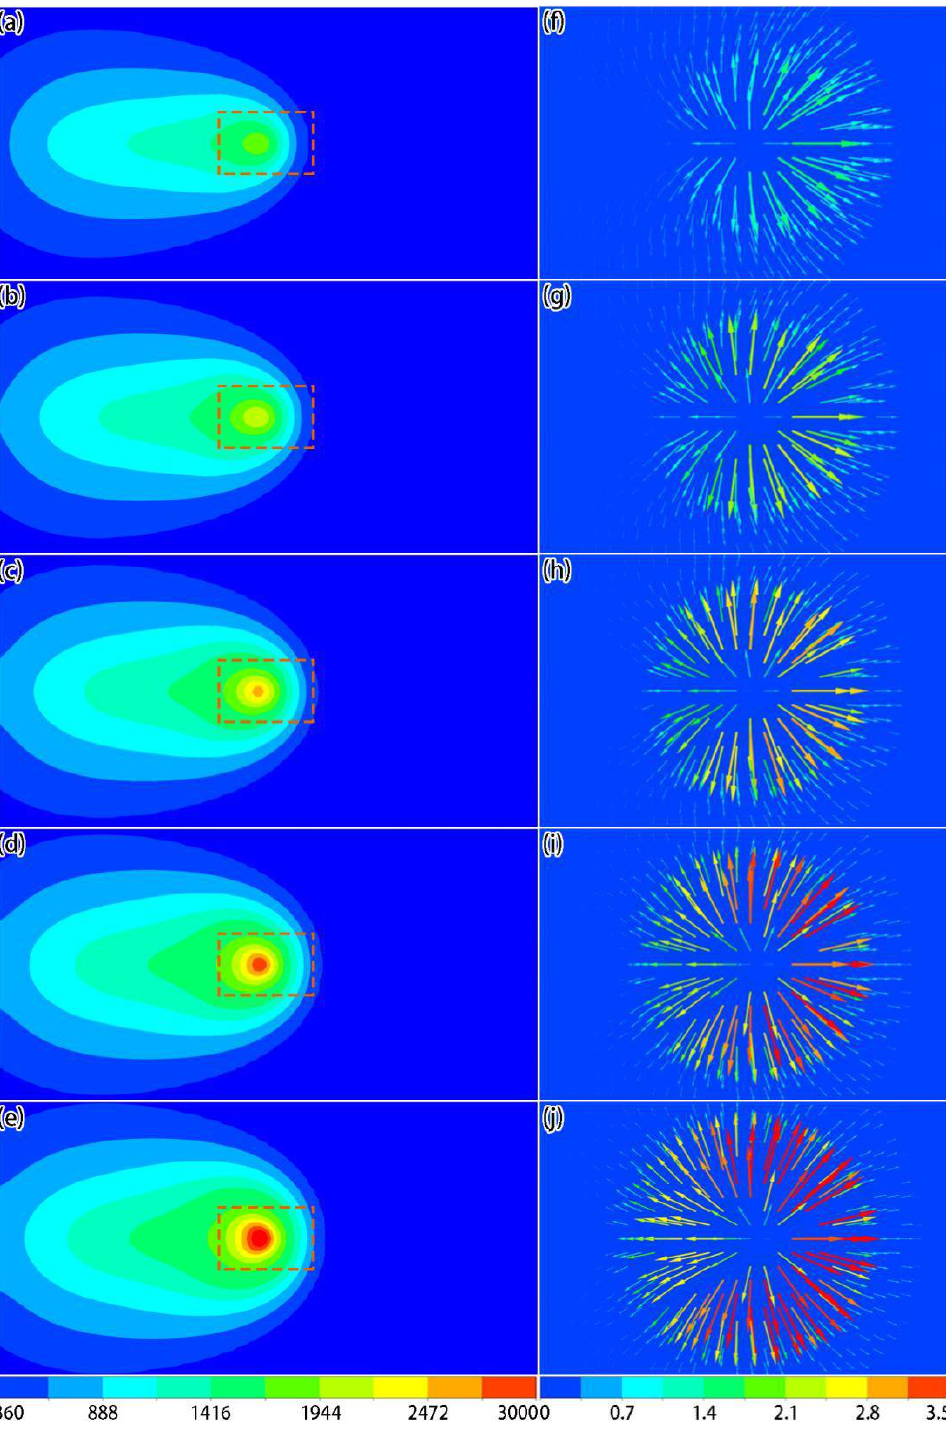
Figure 11. Simulation results of temperature ( a – e , unit: K) and local velocity ( f – j , unit: m/s) distributions on the surface under different laser powers when the laser acted on the center of the powder layer: ( a , f ) 150 W; ( b , g ) 200 W; ( c , h ) 250 W; ( d , i ) 300 W; ( e , j ) 350 W.